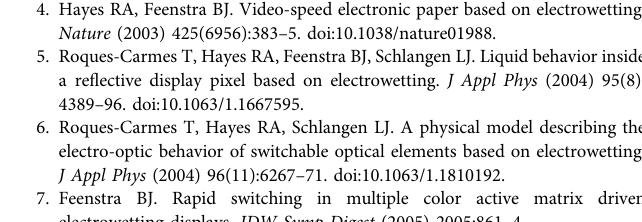
Frontiers in Physics |